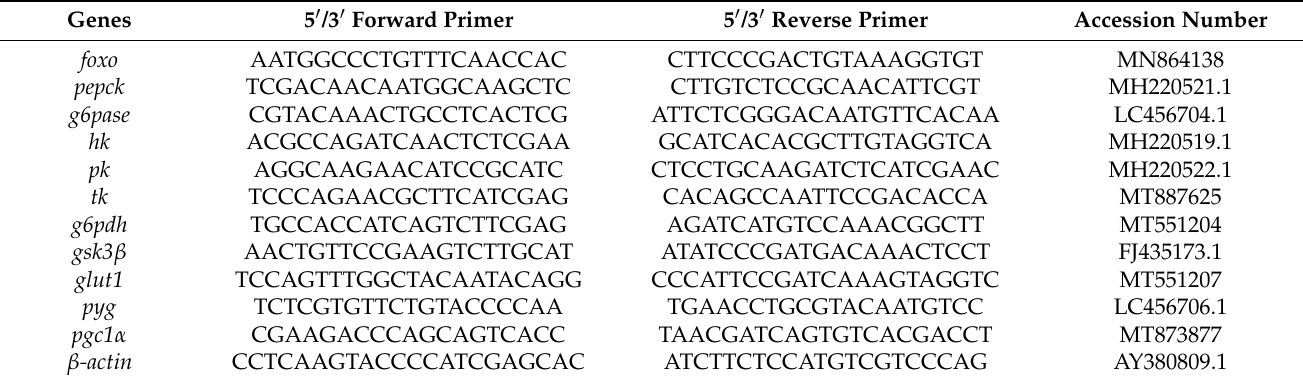
Table 2. List of the primers used for the real-time PCR